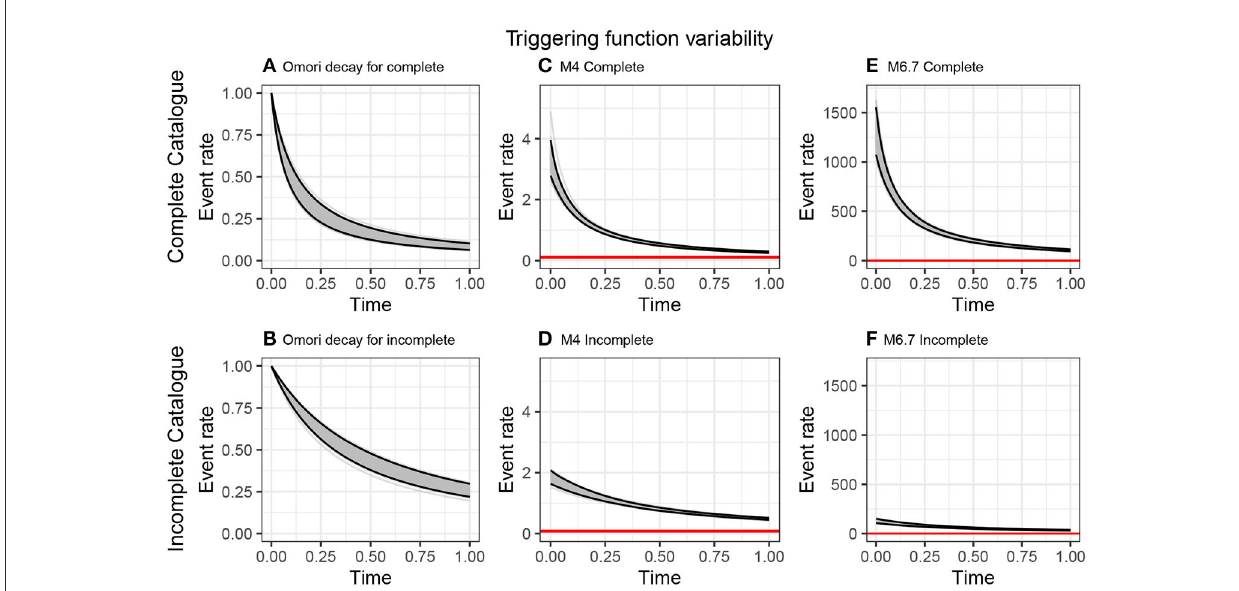
FIGURE12 Propagation of ETAS parameter uncertainty on the triggering functions. We take 100 samples of the ETAS posteriors for the complete 1,000-day catalog with an M6.7 on day 500 (A, C, E) and for the temporally incomplete version of this catalog, as described in the text. We then use these samples to explore variability in the Omori decay (A, B) , the time-triggering function following an M4 event (C, D) , and the time-triggering function following an M7.6 event (E, F)